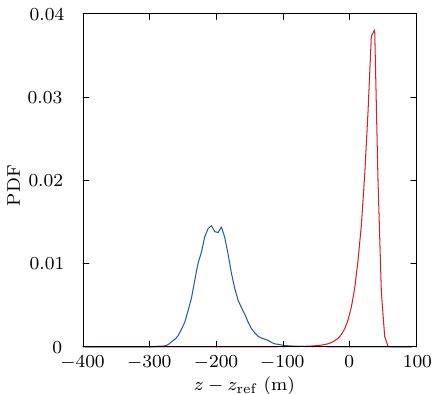
Figure 5. Probability density functions of cloud base and cloud top heights with respect to the height of the maximum mean cloud liquid z ref .